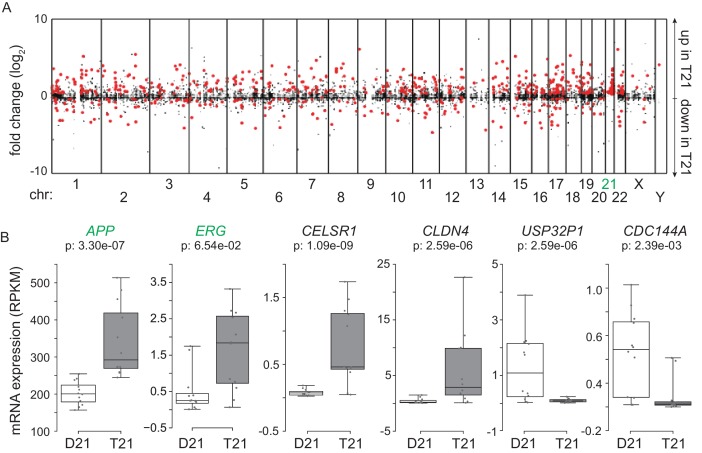
Amplification of changes in gene expression emanating from T21.(A) Manhattan plot showing most DEGs (red) are not encoded on chr21. (B) Example box and whisker plots of chr21 (green) and non-chr21 (black) DEGs. mRNA expression values are displayed in reads per kilobase per million (RPKM). Benjamini-Hochberg adjusted p-values were calculated using DESeq2.